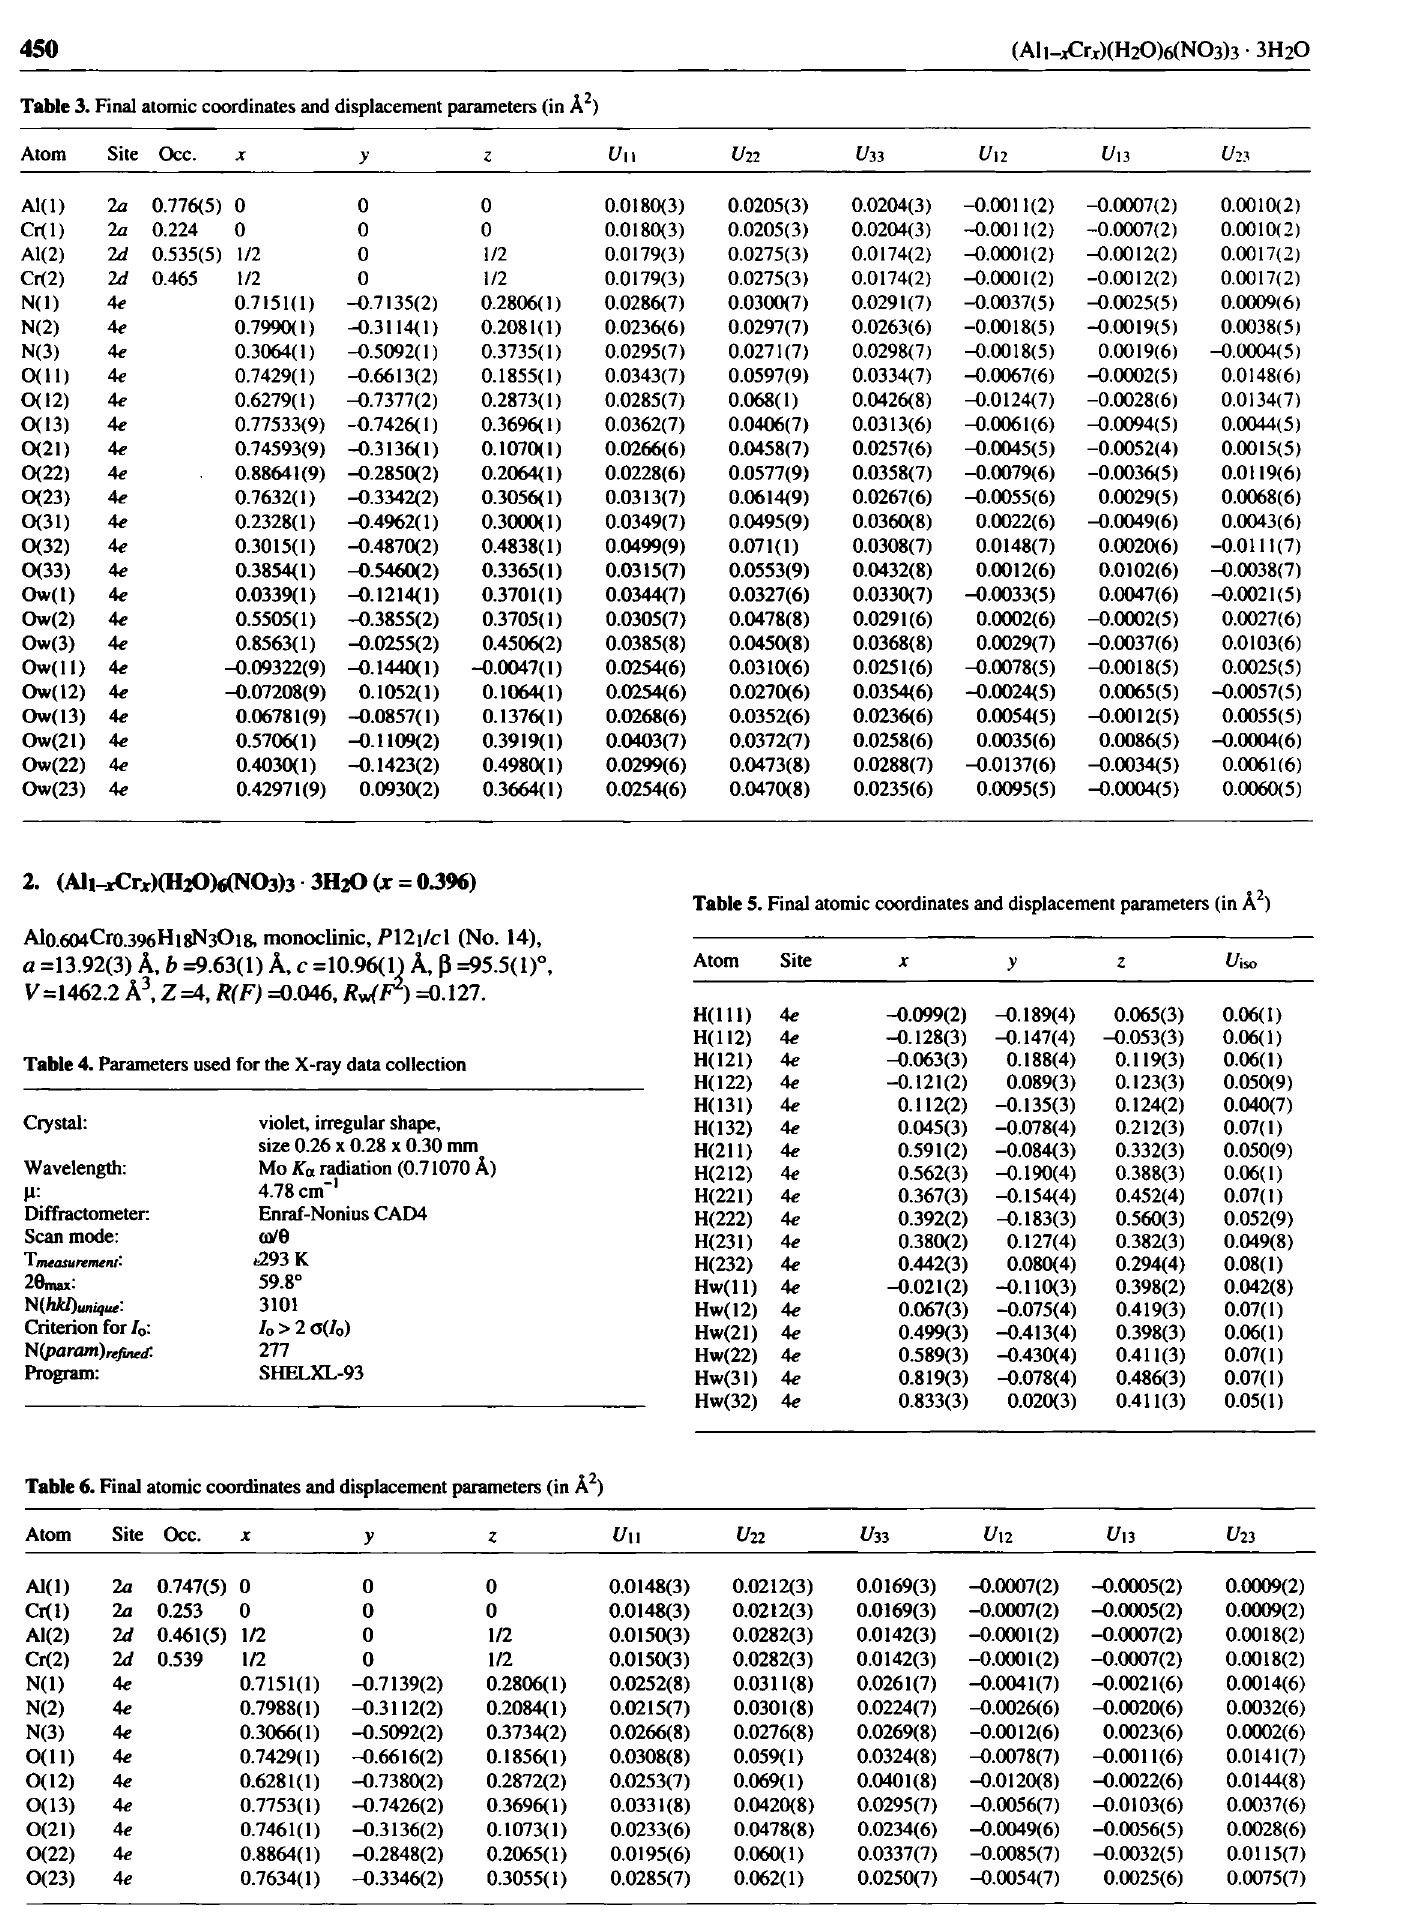
Table 3. Final atomic coordinates and displacement parameters (in Â^) Atom Site Occ.